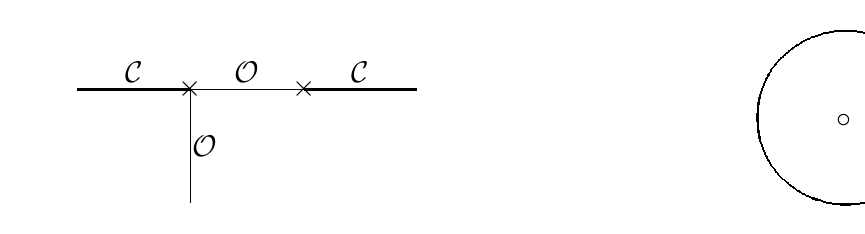
Figure 3 . A Feynman diagram with two external closed strings and one external open string. The right hand diagram is a representation of this as a disk amplitude, with the (cid:14) ’s denoting closed string vertex operator and the ? on the boundary denoting open string vertex